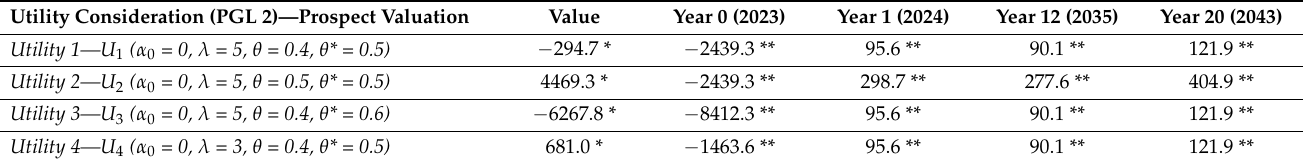
Table 5. Different prospect valuations according to the power utility curve